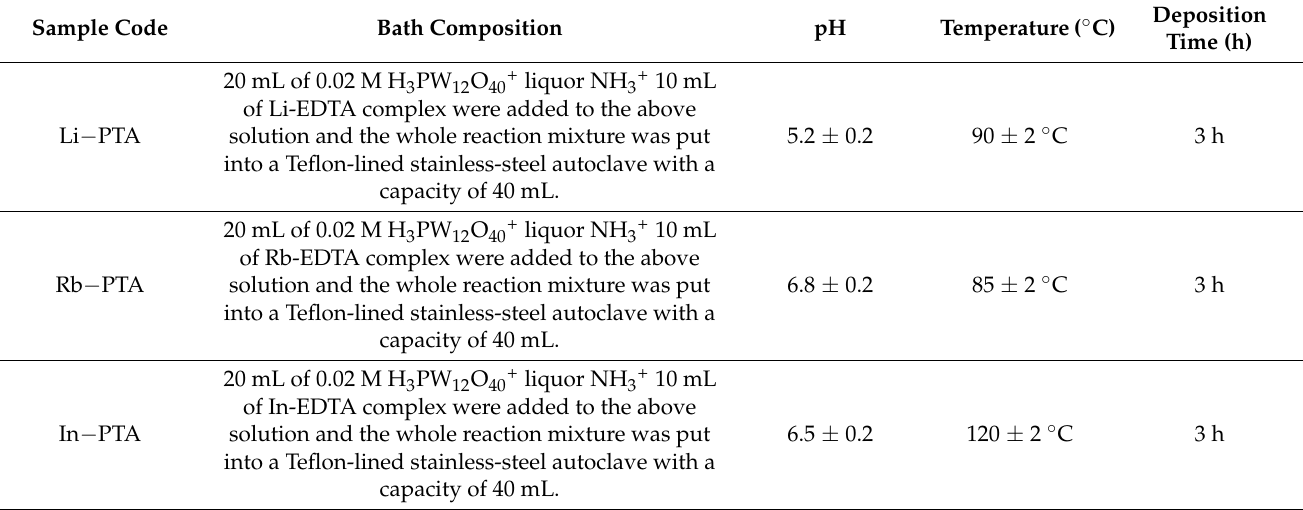
Table 1. Optimized parameters for the synthesis of Li − PTA, Rb − PTA, and In − PTA thin films. Sample